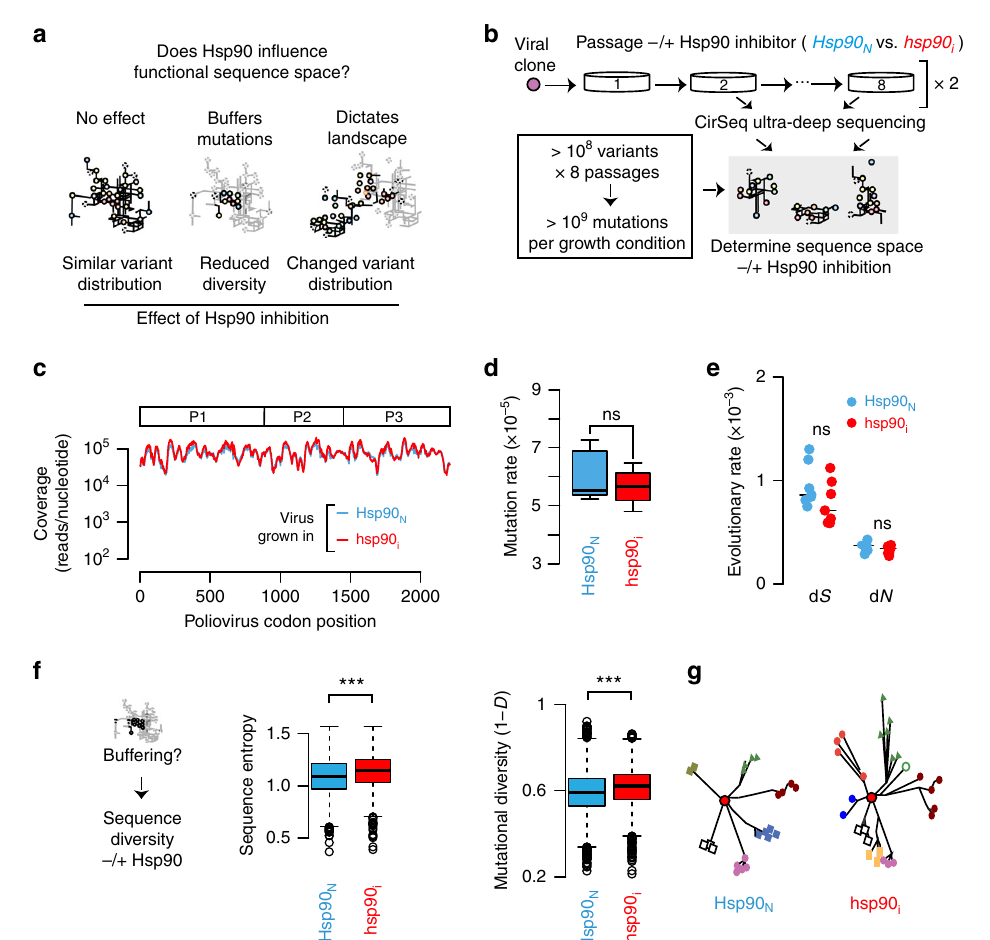
Fig. 2 Globally assessing the in fl uence of Hsp90 on protein sequence space. a Hypothetical models for how Hsp90 in fl uences the functional sequence space of poliovirus: no-effect (left), buffers mutations (center), or dictates landscape (right). Schemes illustrate the respective predicted outcome of Hsp90 inhibition on sequence space for each model. Gray lines indicate available mutational networks while black lines indicated those that are present under the different proposed scenarios. b Experimental strategy to examine the effects of Hsp90 inhibition on poliovirus sequence space. Poliovirus was propagated over eight passages under normal or low Hsp90 conditions via GA treatment. Population samples containing >10 8 variants each were collected from passages 2 – 8 and subjected to CirSeq deep sequencing and analysis. c Average sequence coverage obtained with CirSeq across the poliovirus genome for all populations Hsp90 N (blue trace) and hsp90 i (red traces). d Mutation rates for the full virus genome in Hsp90 N and hsp90 i populations. e Evolutionary rates for P1 in Hsp90 N and hsp90 i populations (full genome in Supplementary Fig. 4c). f Does Hsp90 buffering lead to reduced P1 sequence diversity in hsp90 i populations? Sequence entropy (left panel) and mutational diversity (right panel) for P1 coding region is higher for hsp90 i than for Hsp90 N populations analyzed by CirSeq. g Representation of distinct sequence diversity for P1 from Hsp90 N and hsp90 i virus populations. The original master sequence (red, middle circle) gives rise to variants (different colors and symbols) through mutation. For boxplots, the center line represents the median, the bound box the interquartile range, and the whiskers 1.5× the interquartile range. Signi fi cance: ns, not signi fi cant ( p > 0.05); *** p < 0.005 by